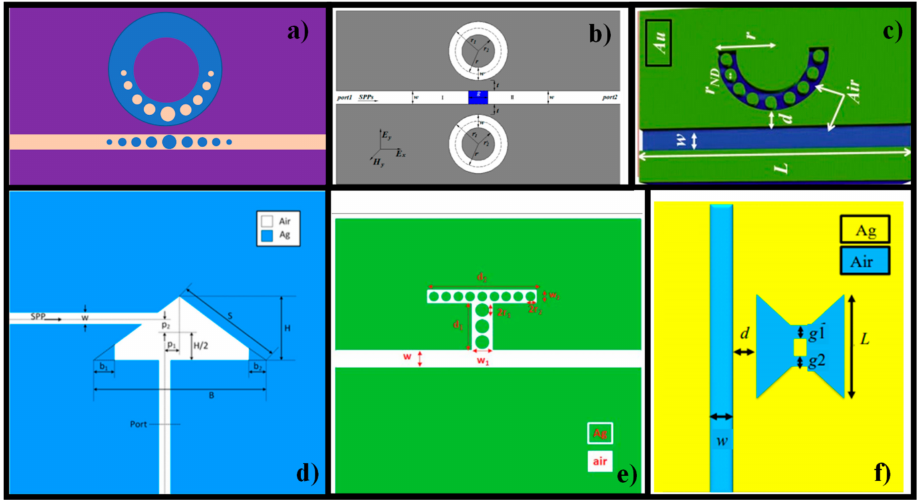
Figure 9. Recently proposed metal-insulator-metal (MIM) WG plasmonic sensors for biochemical applications: ( a ) RR coupled to a MIM WG containing tapered defects. Adapted from ref. [150]; ( b ) tunable plasmonic band-pass filter with dual side-coupled circular RRs. Reprinted from ref. [149]; ( c ) nanodots arranged MIM semi-RR cavity for biochemical sensing applications. Reprinted with per- mission from ref. [17]; ( d ) multiple Fano-like MIM plasmonic arrangement established on triangular resonator for refractive index (RI) sensing. Reprinted from ref. [151]; ( e ) MIM WG-coupled T-shape cavity with metal nanorod defects. Reprinted from ref. [152]; ( f ) plasmonic Bow-Tie configuration. Reprinted from ref.